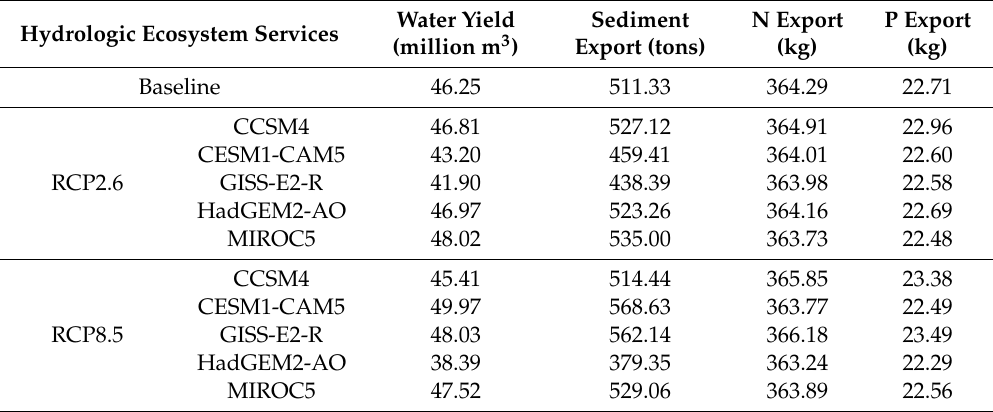
Table 1. Hydrologic ecosystem services calculated for di ff erent climate change scenarios. Hydrologic Ecosystem